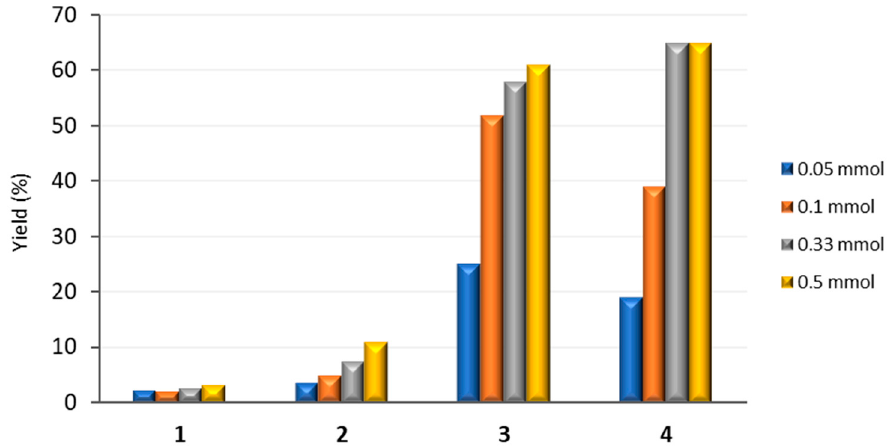
Figure 4. Effect of the catalyst amount (0.05–5 mmol) on acetophenone yield (mol%, vs. substrate) in the MW-assisted peroxidative oxidation of 1-phenylethanol, catalyzed by 1 – 4 . Reaction conditions: 5 mmol substrate, 5 mmol t -BuOOH (aq. 70%), 80 °C, 1 h, MW irradiation (5–10 W).